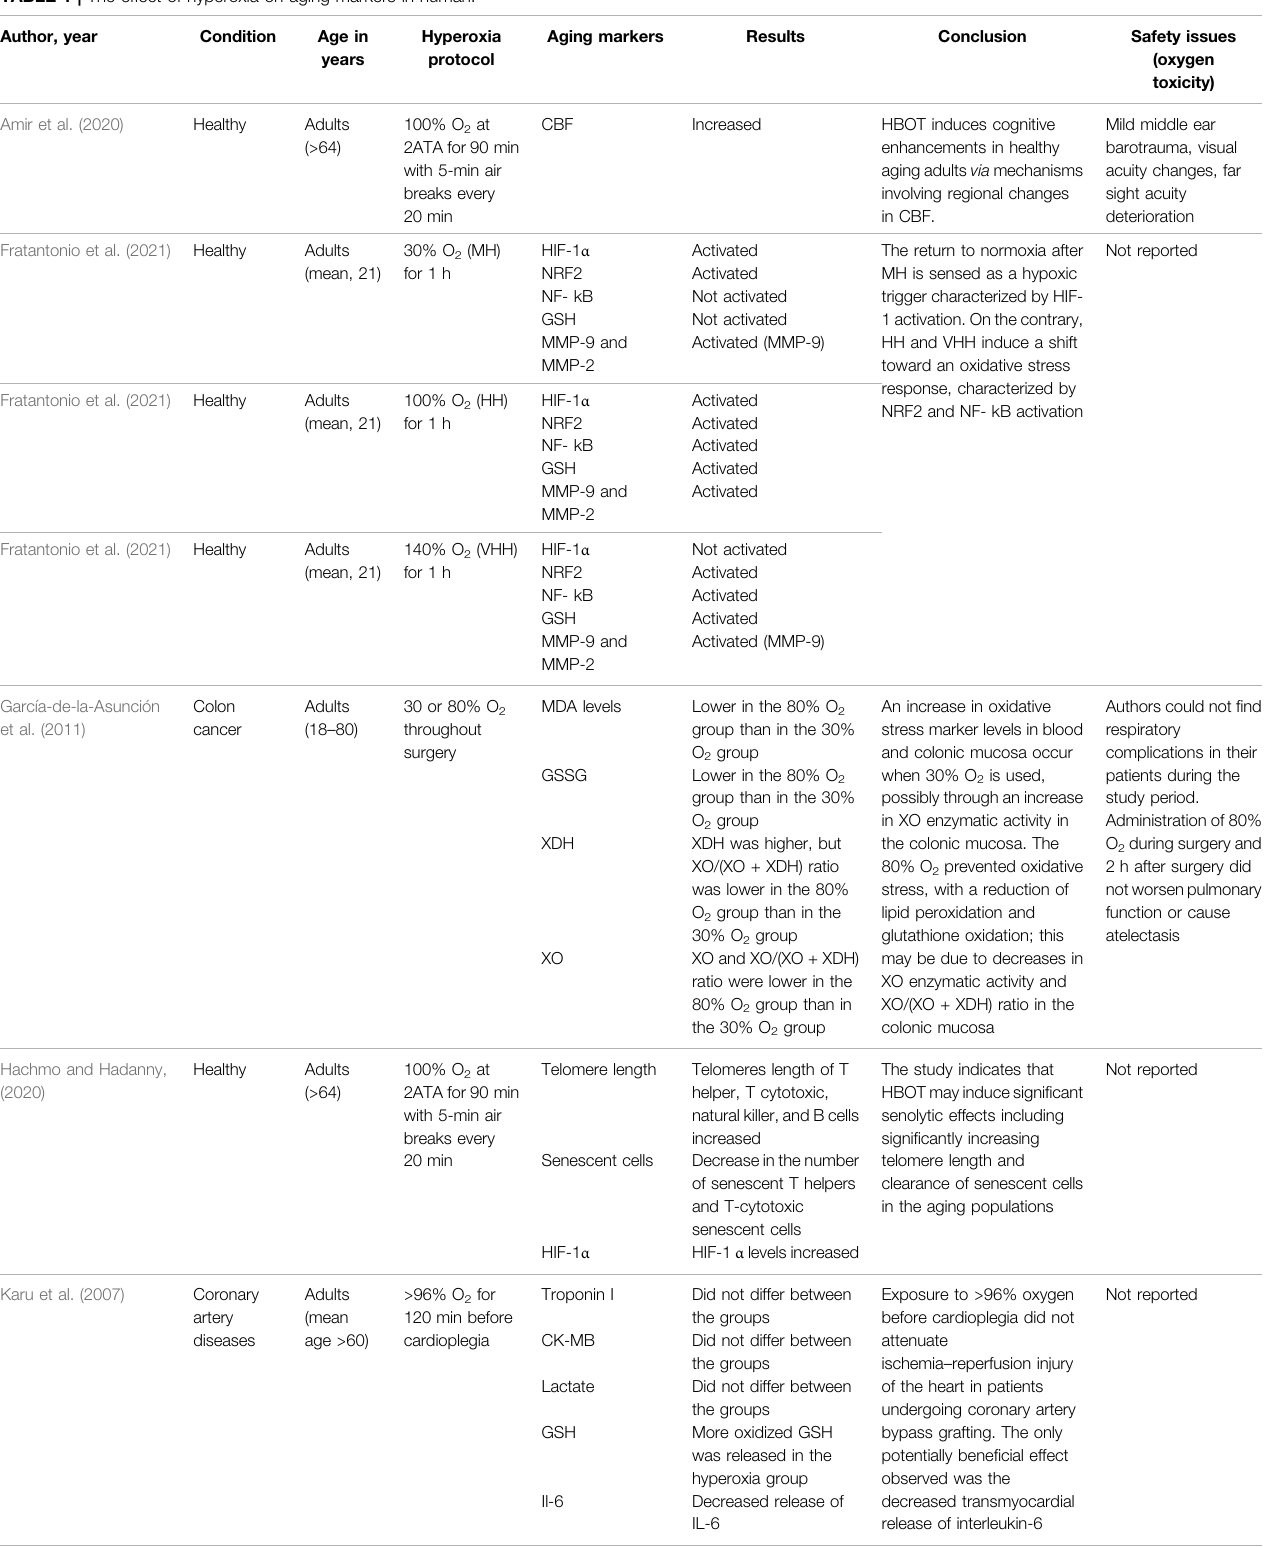
TABLE 1 | The effect of hyperoxia on aging markers in